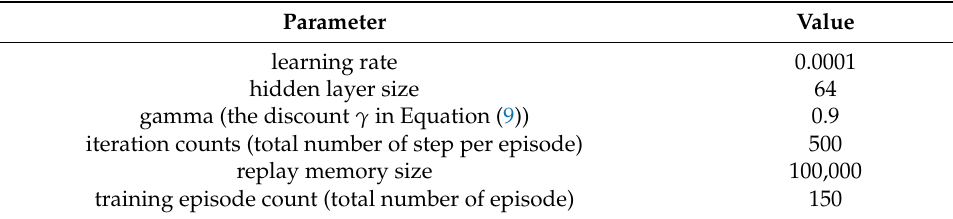
Table 5. The list of